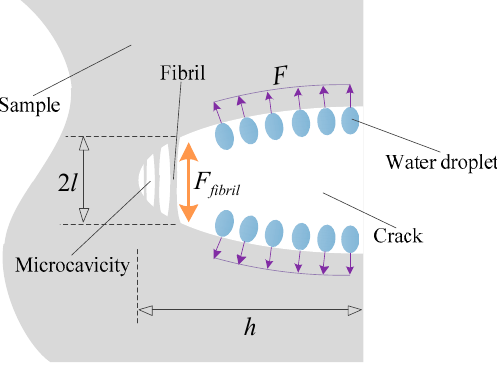
Figure 6. Schematic of the crack in the uniaxial stress imposed by water droplets.